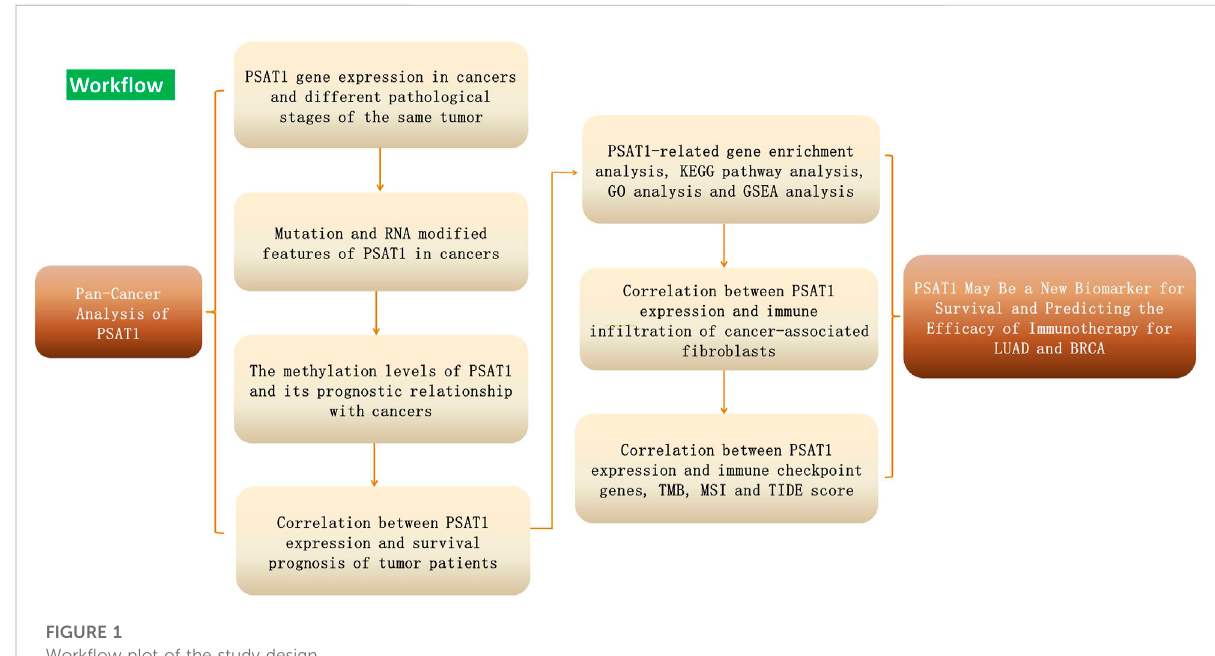
FIGURE 1 Work fl ow plot of the study